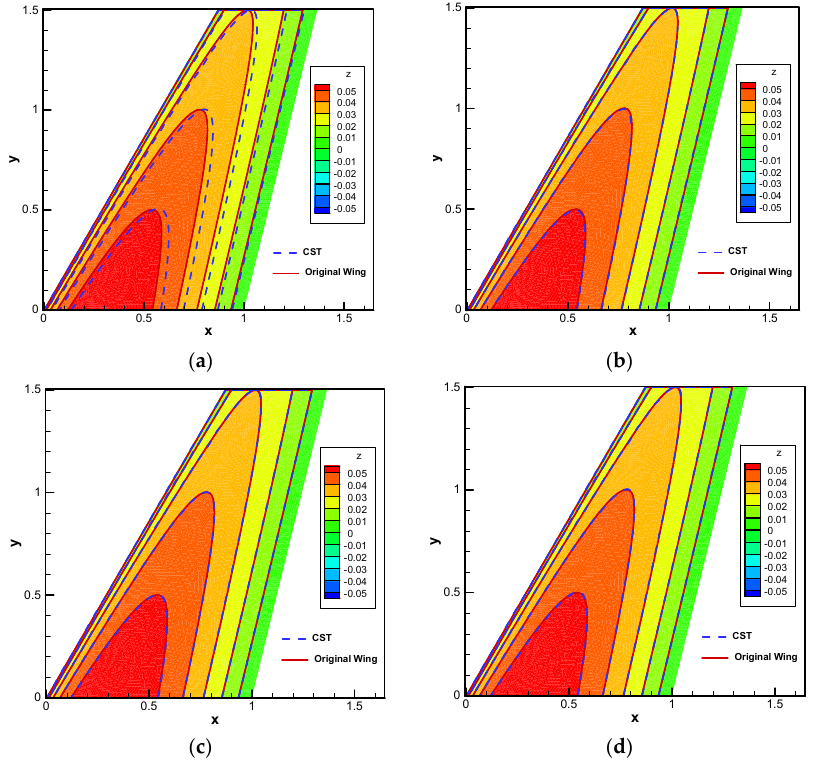
= = 6); 𝒊,𝒋 i , j = 𝟐𝟒 ). = 24 𝒊,𝒋 b i , j